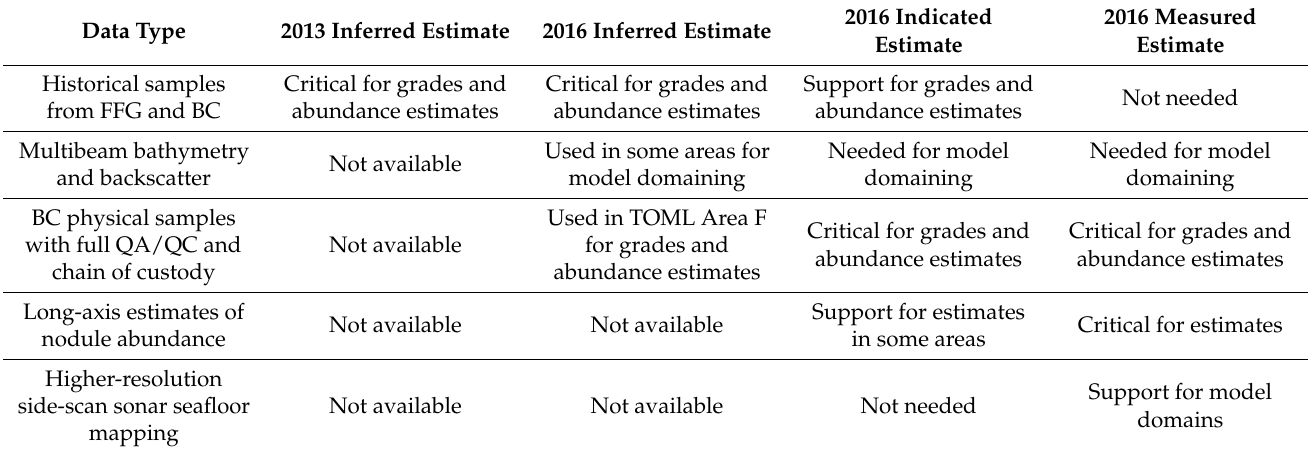
Table 2. Data matrix for the Tonga Offshore Mining Limited mineral resource